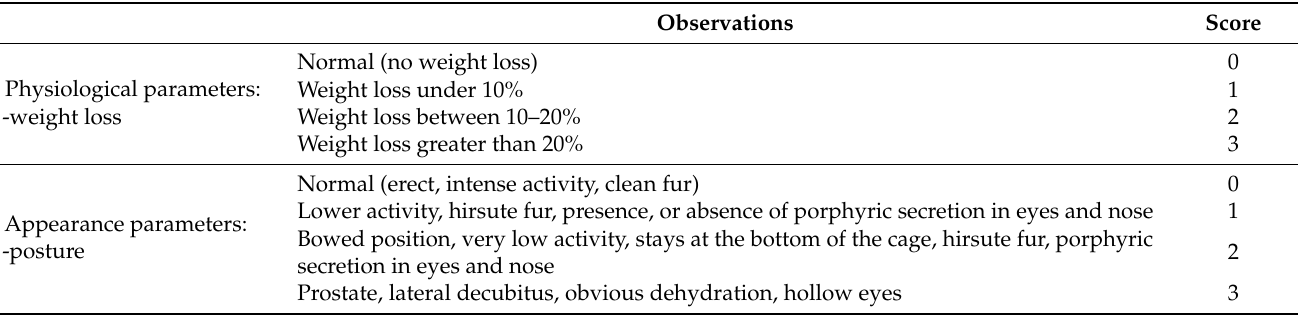
Table A1. Daily supervision chart for S. Typhimurium infected C57BL/6J female